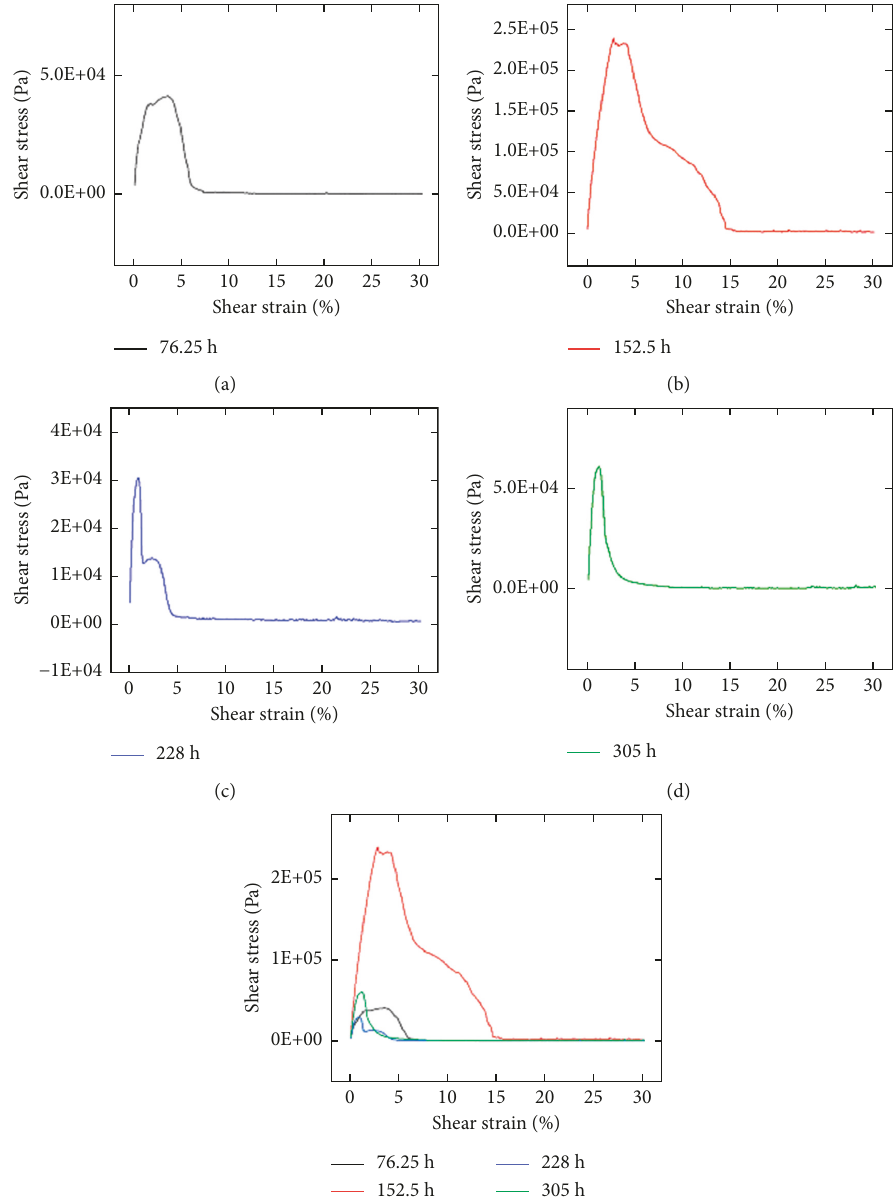
Figure 11: LAS results of T770 modified asphalt subjected to different UV aging